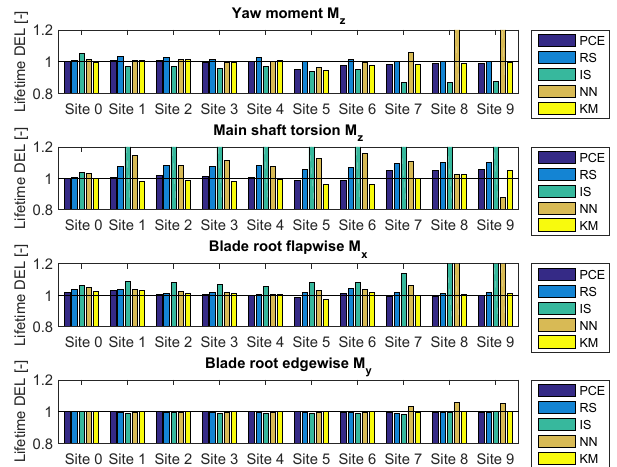
Figure 10. Predictions of lifetime damage-equivalent tower loads for five different estimation approaches and four load channels for the different sites (0–6) and IEC conditions (virtual sites 7–9). All values are normalized with respect to the mean estimate from a site- specific Monte Carlo (MC) simulation. The abbreviations refer to PCE: polynomial chaos expansion; RS: quadratic response surface; IS: importance sampling; NN: nearest-neighbor interpolation; and KM: universal Kriging model.